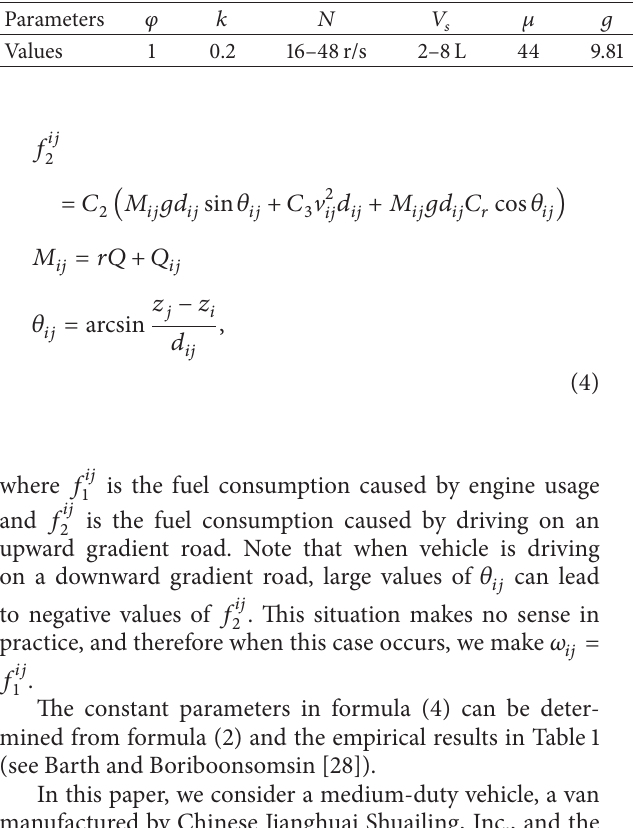
Table 1: Values of parameters affecting vehicle fuel